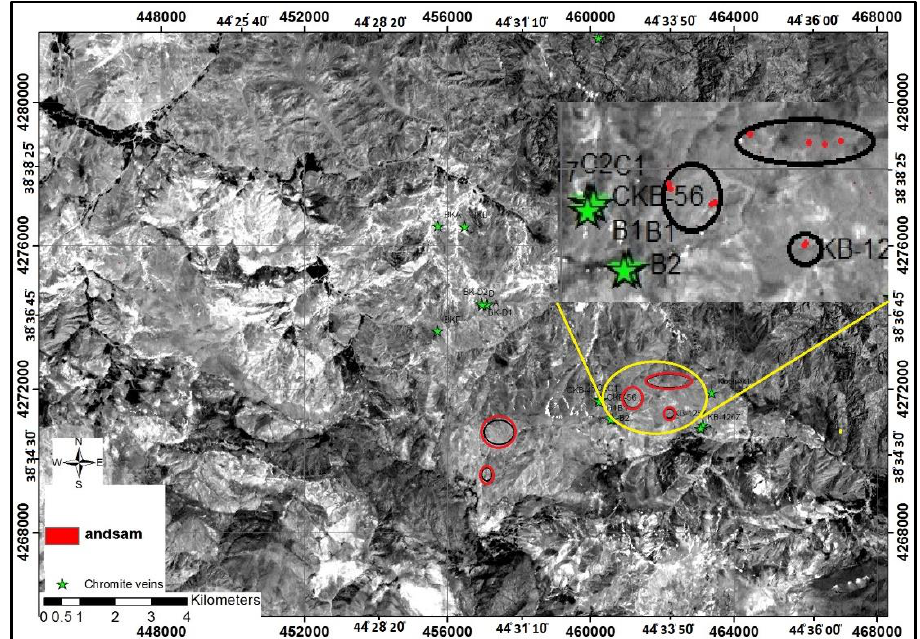
Figure 18. Chromitite-bearing pixels obtained from Anomaly D spectra and SAM in ASTER data.